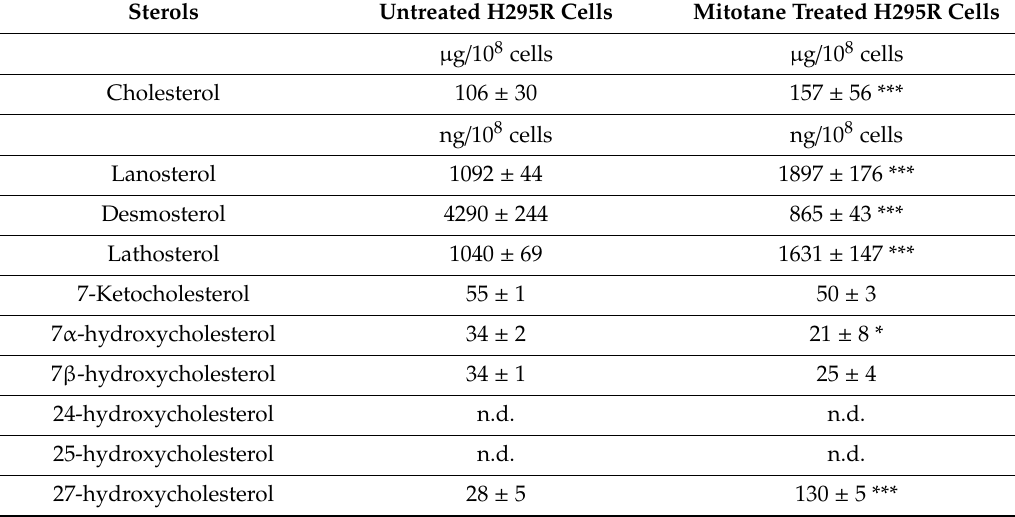
Table 2. Cholesterol, cholesterol precursors and oxysterols in H295R